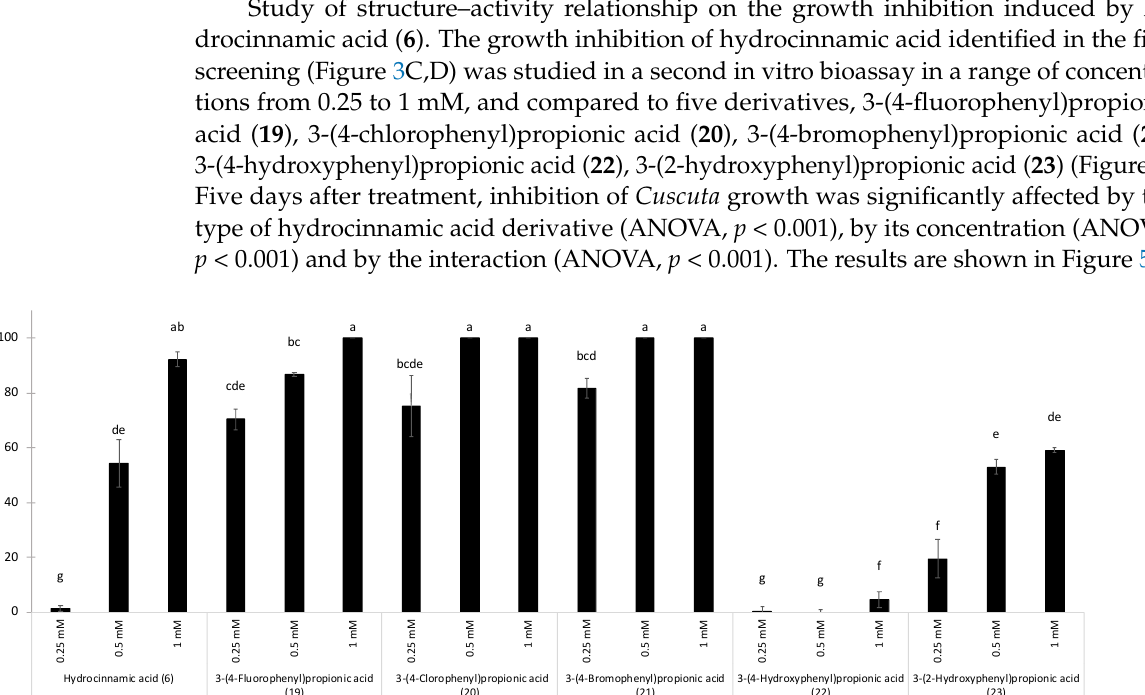
Figure 4. In vitro assessment of the Cuscuta growth inhibition induced by 2-benzoxazolinone ( 6 ) and its derivatives ( 24 – 27 ). Bars with different letters are significantly different (Tukey test at p < 0.05). Error bars represent the standard error of the mean.